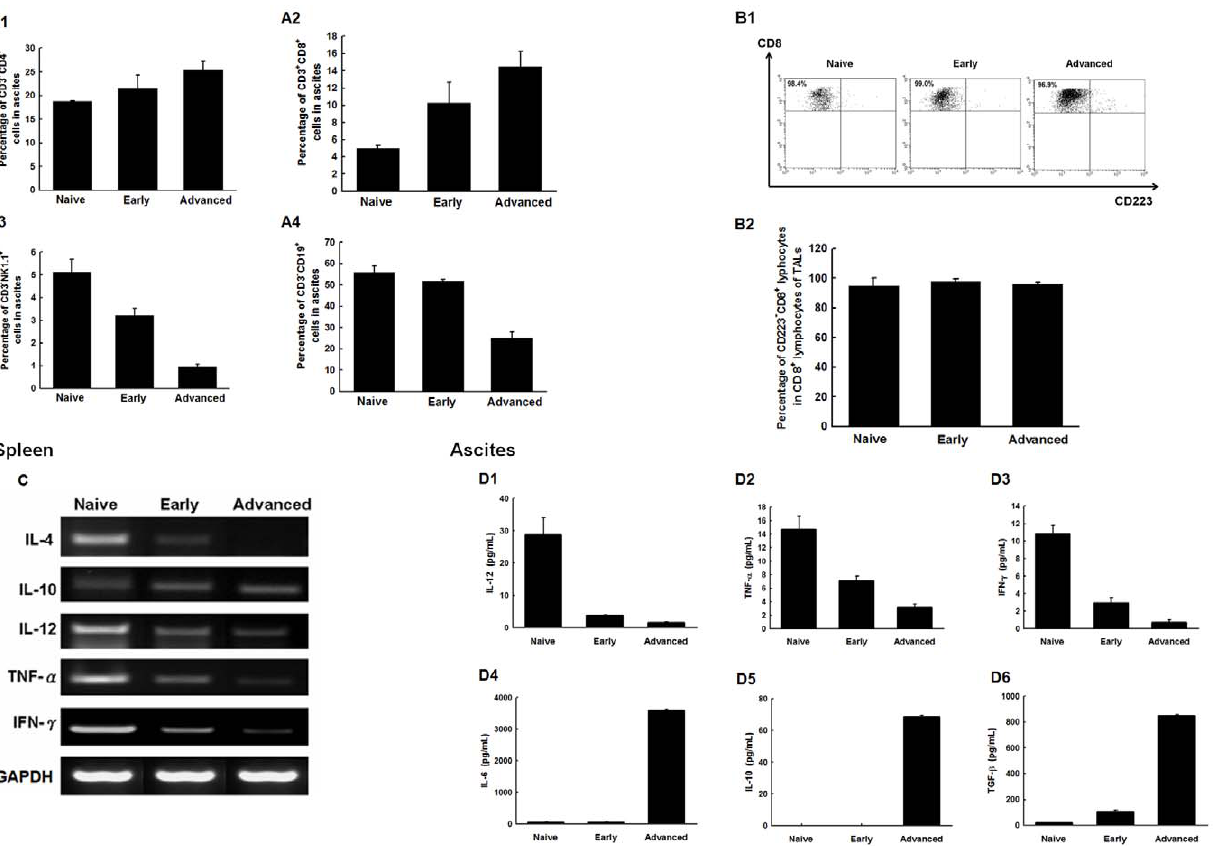
Figure 3. Kinetic changes of local immune effector cells in TACs of mice challenged with PBS or WF-3 tumor cells. ( A ) Percentages of various kinds of lymphocytes in TACs of naı¨ve mice and mice of early and advanced diseases. A1, CD4 + helper T lymphocytes; A2, CD8 + cytotoxic T lymphocytes; A3, NK1.1 + natural killer cells; and A4, CD19 + B lymphocytes. Note : For helper and cytotoxic T lymphocytes, the percentages on TACs increased from early to advanced disease. However, the percentages of natural killer cells and lymphocytes in TACs significantly decreased with tumor progression. ( B ) CD223 2 CD8 + lymphocytes in TACs of mice. B1: Representative figures of flow cytometric analyses of CD223 2 CD8 + and CD223 + CD8 + lymphocytes in TACs. B2: Percentages of CD223 2 CD8 + lymphocytes in TACs of mice. Note : Majority of CD8 + cytotoxic T lymphocytes were non-activated as the disease progressed to advanced status. ( C ) The RT-PCR of various cytokines in splenocytes of mice challenged with PBS or WF-3 tumor cells. Note : The expression levels of IL-4, IL-12, TNF- a , and INF- c decreased but the expression levels of IL-10 increased gradually as the disease progressed. ( D ) The concentrations of various cytokines by ELISA in ascites of mice challenged with PBS or WF-3 tumor cells. D1, IL-12; D2, TNF- a ; D3, IFN- c ; D4, IL-6; D5, IL-10; D6, TGF- b . Note : The concentrations of IL-6, IL-10, and TGF- b were elevated but those of IL-12, TNF- a , and IFN- c decreased as the tumor progressed.